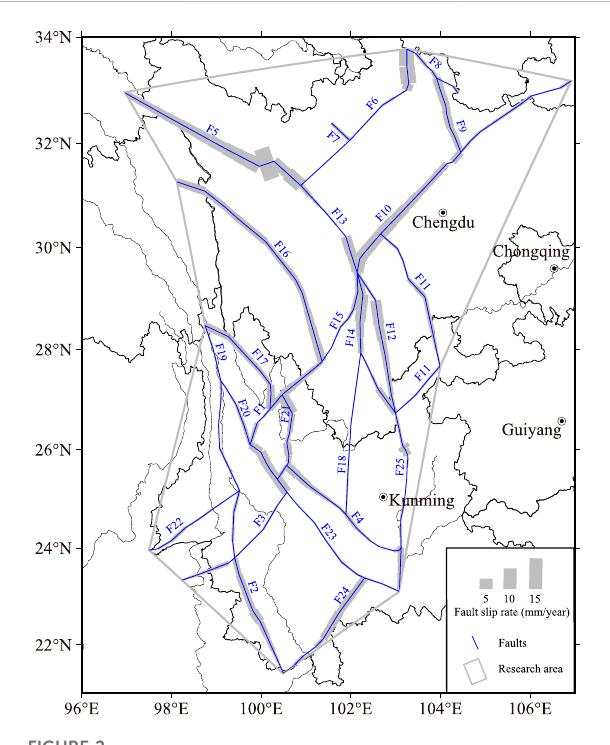
FIGURE 2 Fault slip rates. The blue lines indicate the faults in the fault-model database in the test area, with line thicknesses proportional to the fault slip rate. The gray line encloses the test area in the Sichuan-Yunnan region. The fault numbers are as indicated in Figure